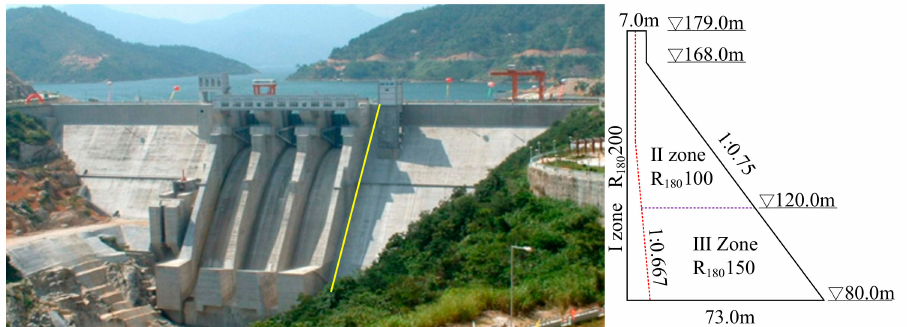
Figure 12. The roller compacted concrete (RCC) dam and its non-flow dam section.